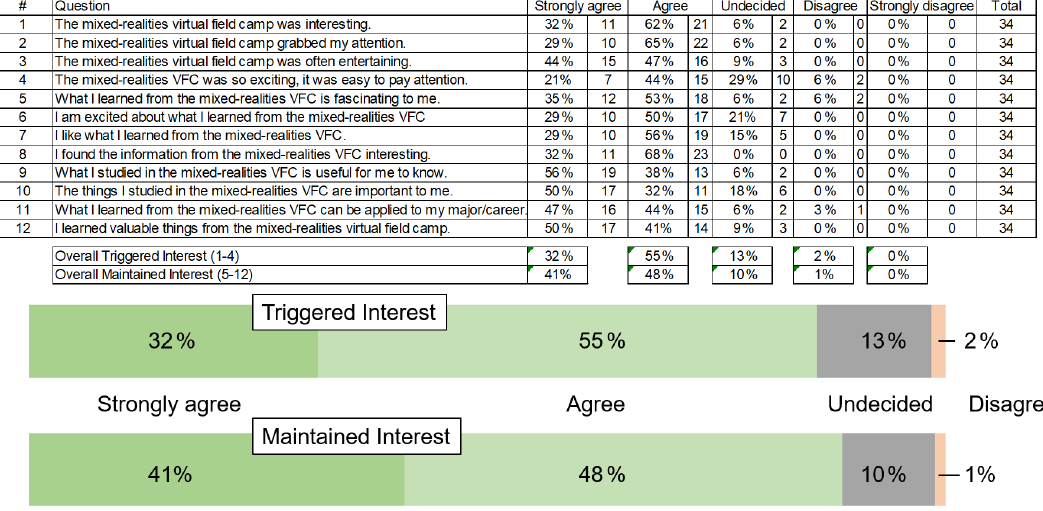
Figure 4. Evaluations of students’ perception of the value of the virtual field camp were overall very positive. Students agreed or strongly agreed with a variety of statements that assessed positive interest and